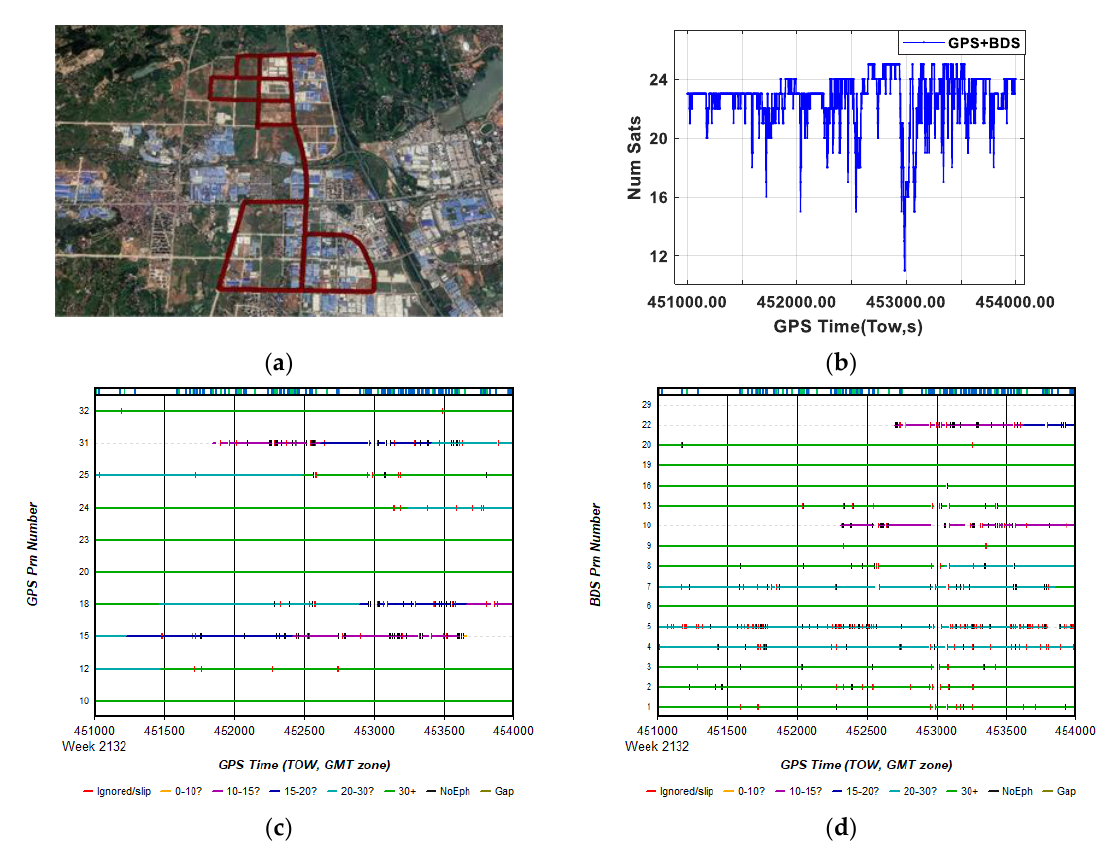
Figure 3. First experiment in an open environment: ( a ) trajectory of vehicle; ( b ) number of visible satellites of the primary baseline; ( c ) the GPS L1 “Satellite Lock—Cycle Slips” plot from IE; ( d ) the BDS B1 “Satellite Lock—Cycle Slips” plot from IE.